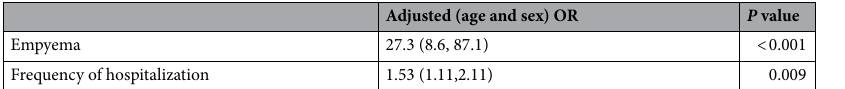
Table 2. Age- and sex-adjusted OR for risk factors associated with surgical intervention in childhood pleural TB. TB tuberculosis, OR odds ratio, CI confidence